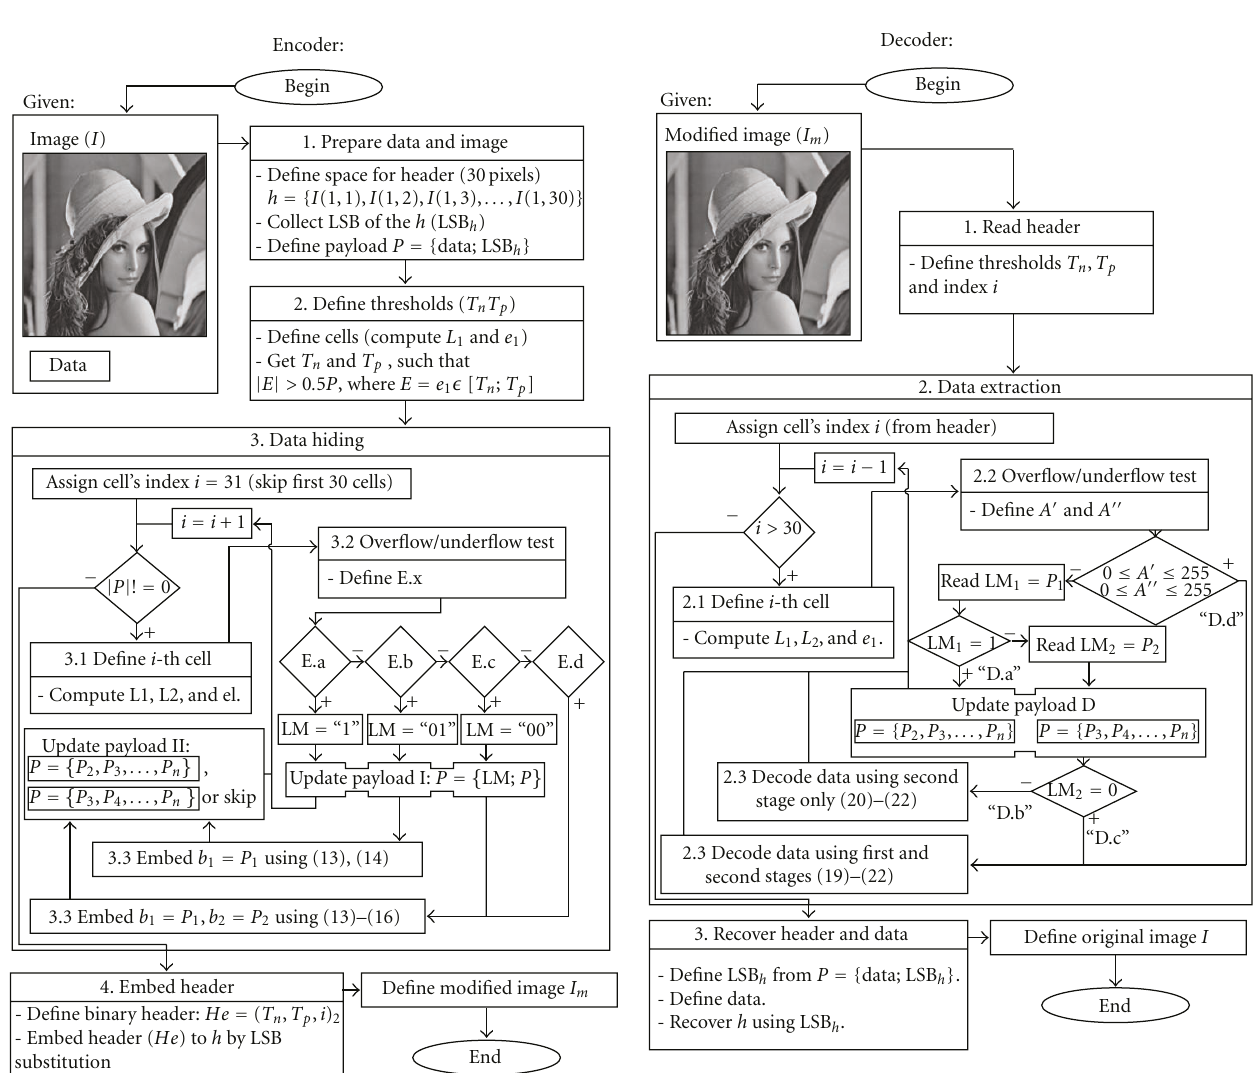
Figure 5: Flowchart of the encoder and